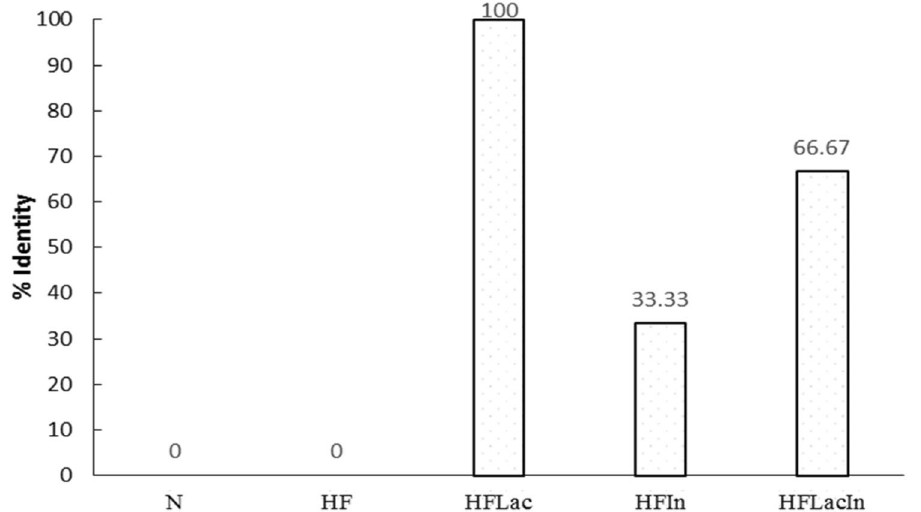
Figure 5. Presence of L. acidophilus in rat feces in each group (n = 13). (N) Rat fed a normal diet (HF) Rats fed with a high fat diet (HFLac, HFIn, HFLacIn). Rats fed with a high fat diet and L. acidophilus , inulin, and L. acidophilus + inulin, respectively. % identity values are